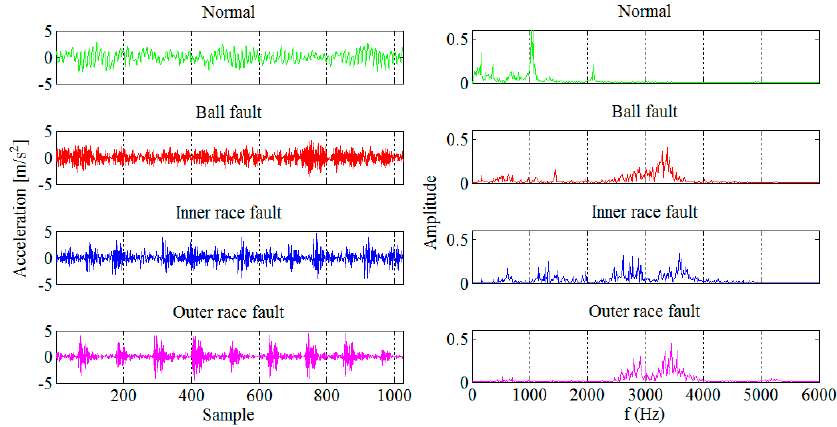
Figure 7. Segments of the vibration signals collected from four different conditions of the ball bearing ( left ) and their frequency spectra ( right ).